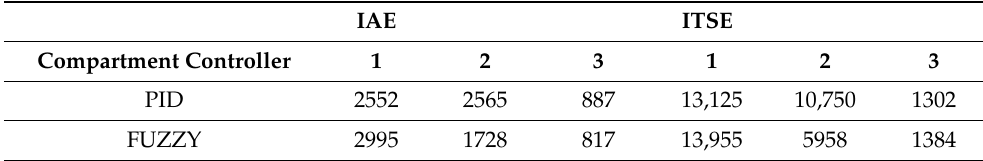
Table 2. Results of adopted control quality